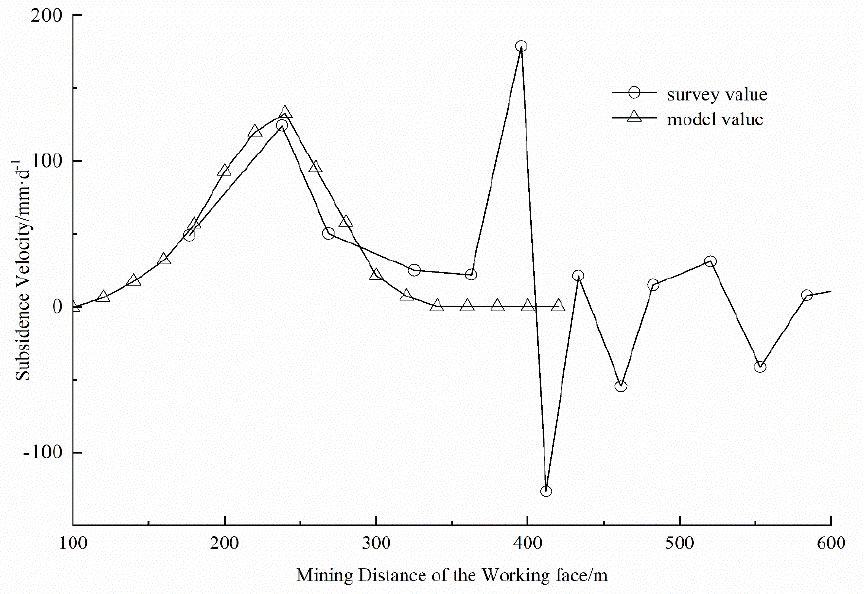
Figure 11. Surface subsidence velocity between the numerical modeling and the survey data.